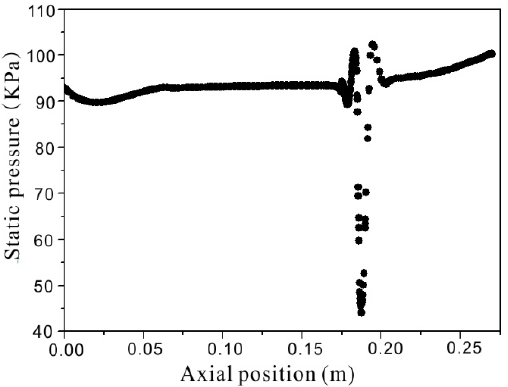
Figure 5. Distribution of static pressure near the wall along the axial direction of the center passage.